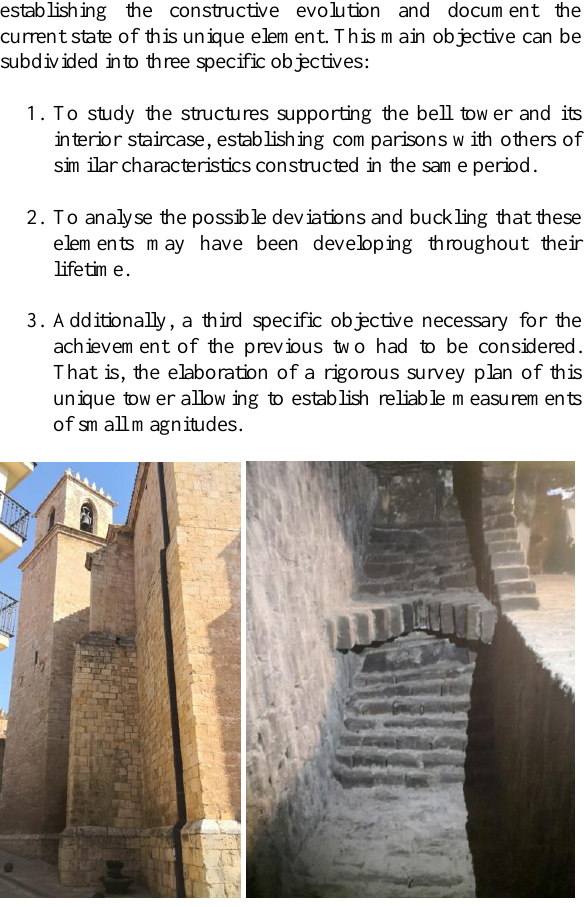
Figure 2. Exterior and interior of the bell tower.